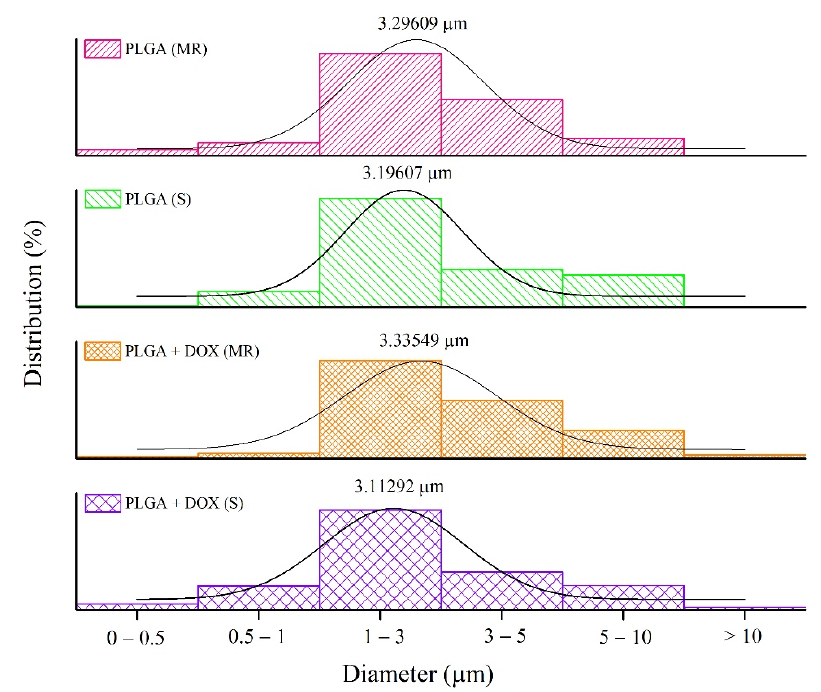
Figure 4. Particle size distribution of PLGA and PLGA + DOX microspheres submitted to sonication (S) and magnetic rotation (MR) (histogram and Gaussian fit).